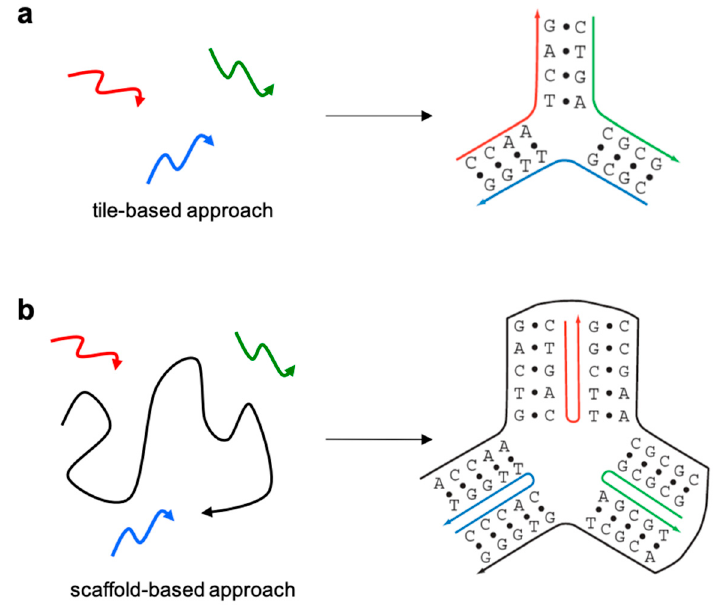
Figure1. Schematicrepresentationofthetwomaindesignstrategiescurrentlyadoptedfortherealization Figure 1. Schematic representation of the two main design strategies currently adopted for the of DNA nanostructures: ( a ) the tile-based and ( b ) the sca ff old-based (or DNA origami) realization of DNA nanostructures: ( a ) the tile-based and ( b ) the scaffold-based (or DNA origami) approach.